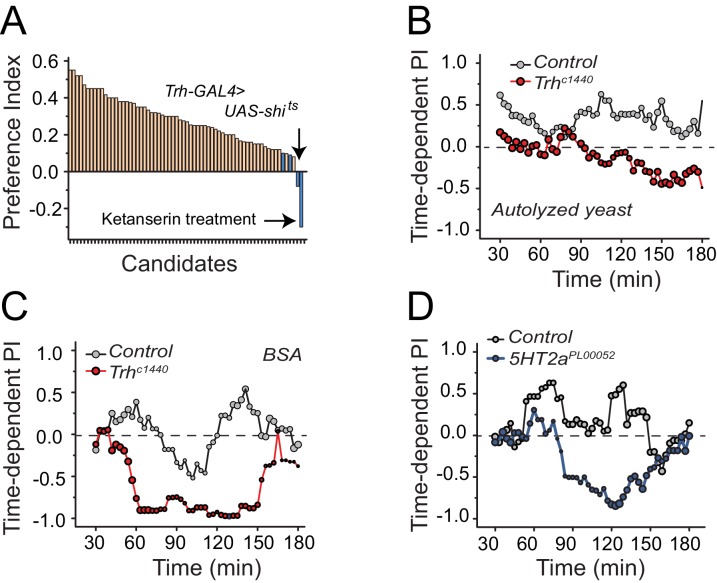
Serotonin signaling through receptor 2a modulates protein preference.(A) Summary results from a candidate reverse genetic screen. We found that disruption of serotonin signaling consistently abrogates protein preference (See Supplementary file 1 for listed candidates). We used BSA as the protein source. Blue bars indicate manipulations of serotonin signaling that strongly disrupted protein preference. (B-C) Time-dependent PI plot from 24 hr-starved Trh mutant and control flies given a choice between sucrose-only or sucrose plus autolyzed yeast or BSA. When the protein source was autolyzed yeast, the cumulative preference index for Canton S files was 0.43 ± 0.1 (Mean ± SEM) whereas Trh mutant flies was −0.18 ± 0.06 (Student's t-test; P≤0.001). When the protein source was BSA, cumulative PI for Canton S. files was 0 ± 0.1 whereas Trh mutant flies was −0.43 ± 0.2 (Student's t-test; P≤0.05). (D) Time-dependent PI plot from 24 hr-starved flies with 5HT2aPL00052 mutant allele and Canton S., control flies given a choice between sucrose-only or sucrose plus BSA. Cumulative PI for the control was 0.2 ± 0.2 and for the mutant was −0.21 ± 0.2 (Student's t-test).